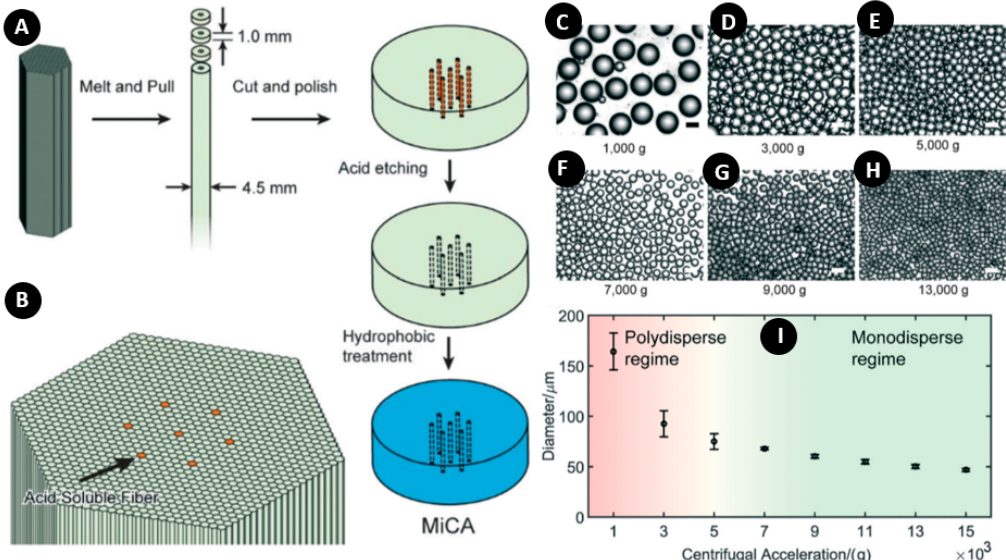
Figure 9. ( A ) Microchannel array (MiCA) fabrication and characteristics; ( B ) Acid-soluble fibers within the bundles; ( C – H ) Microscope images of the produced droplets in various centrifugal accelerations; ( I ) Morphology and size of droplets generated at various centrifugal accelerations. Reprinted with permission from [64].